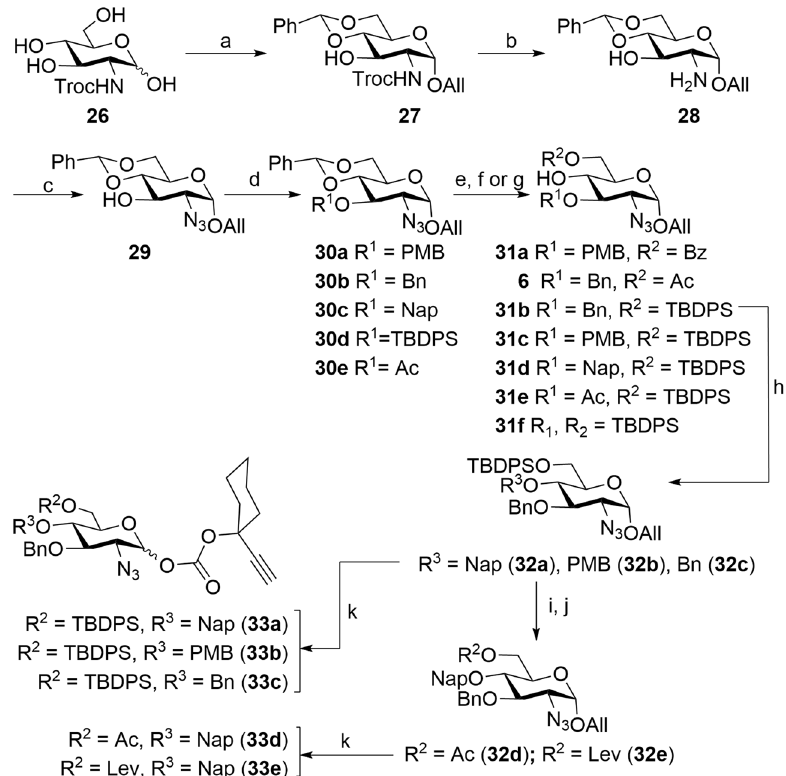
Fig. 3 Synthesis of glucosamine building blocks reagents. a (i) AcCl, AllOH, 0 – 80 °C, 16 h, 94%; (ii) PhCH(OMe) 2 , CSA, DMF, 25 °C, 4 h, 74%; b